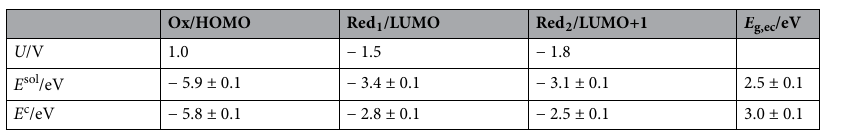
Table 1. Reduction and oxidation potentials of PTTE solved in CH 2 Cl 2 referenced to the internal standard Fc/Fc + , with [N(n-Bu) 4 ]PF 6 as supporting electrolyte, a Pt working electrode, and at a scan rate of v = 50V/s